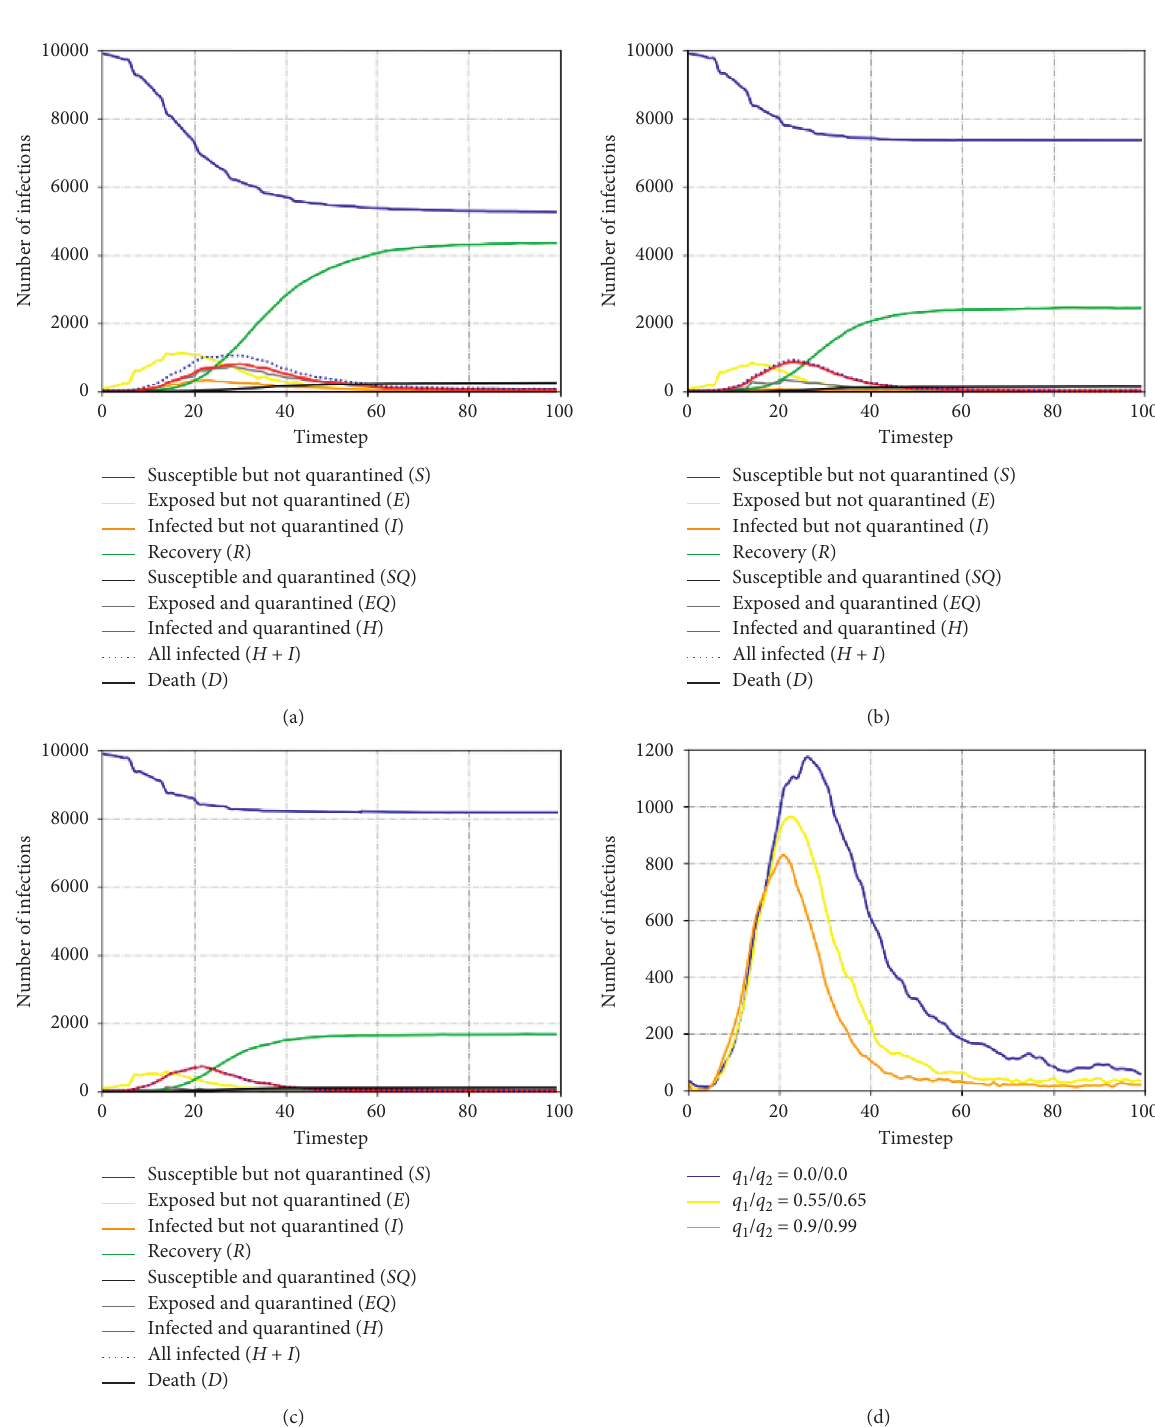
Figure 3: Simulated pandemic under different isolation ratios: (a) q q / q 1 2